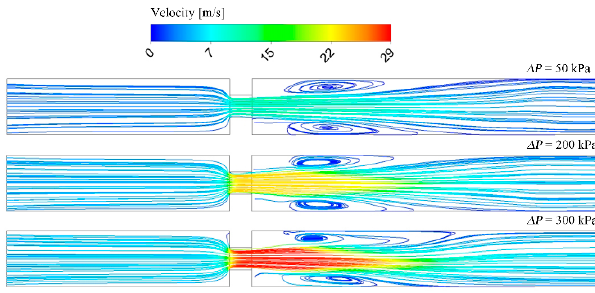
Figure 4. Velocity and streamline on the symmetry plane.